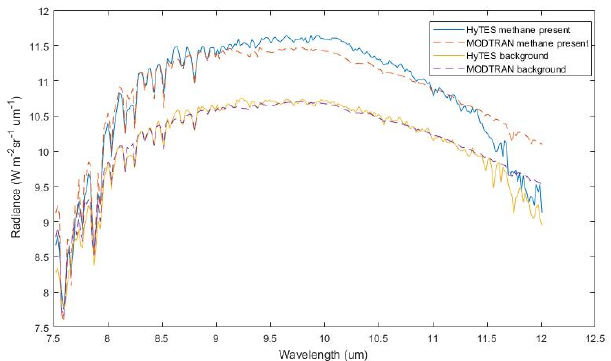
Figure 3. Recreation of HyTES spectra from data set used by Kuai et al. (2016) using MODTRAN 6. This is the recreation of one on- plume and one off-plume pixel from the 5 February 2015 data set.